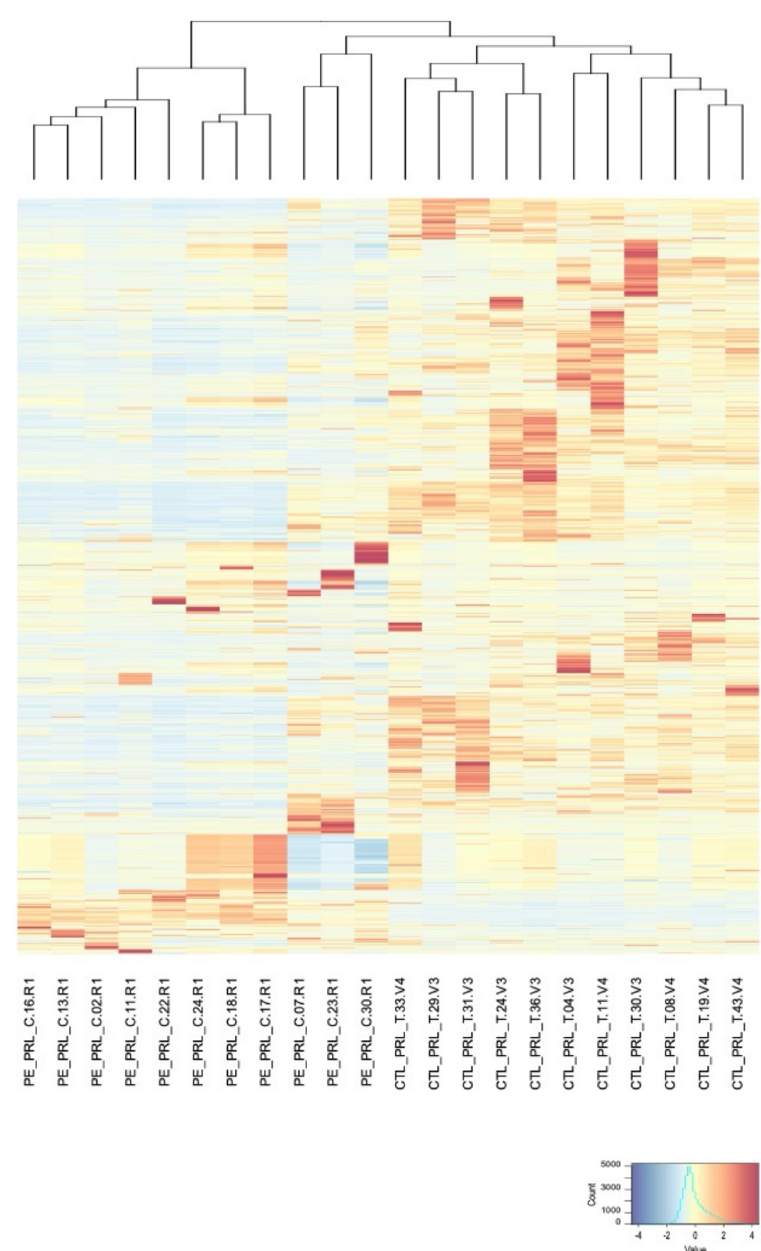
Figure 2. Heatmap of the expression of the 1108 proteins extracted from the proteomic analysis. Colors correspond to the centered intensity values of each protein in each urine sample from blue (smallest intensity) to red (highest intensity). The proteins (in lines) and the samples (in columns) are presented as clustered according to a complete linkage clustering method; the corresponding dendro-gram is shown only for samples.